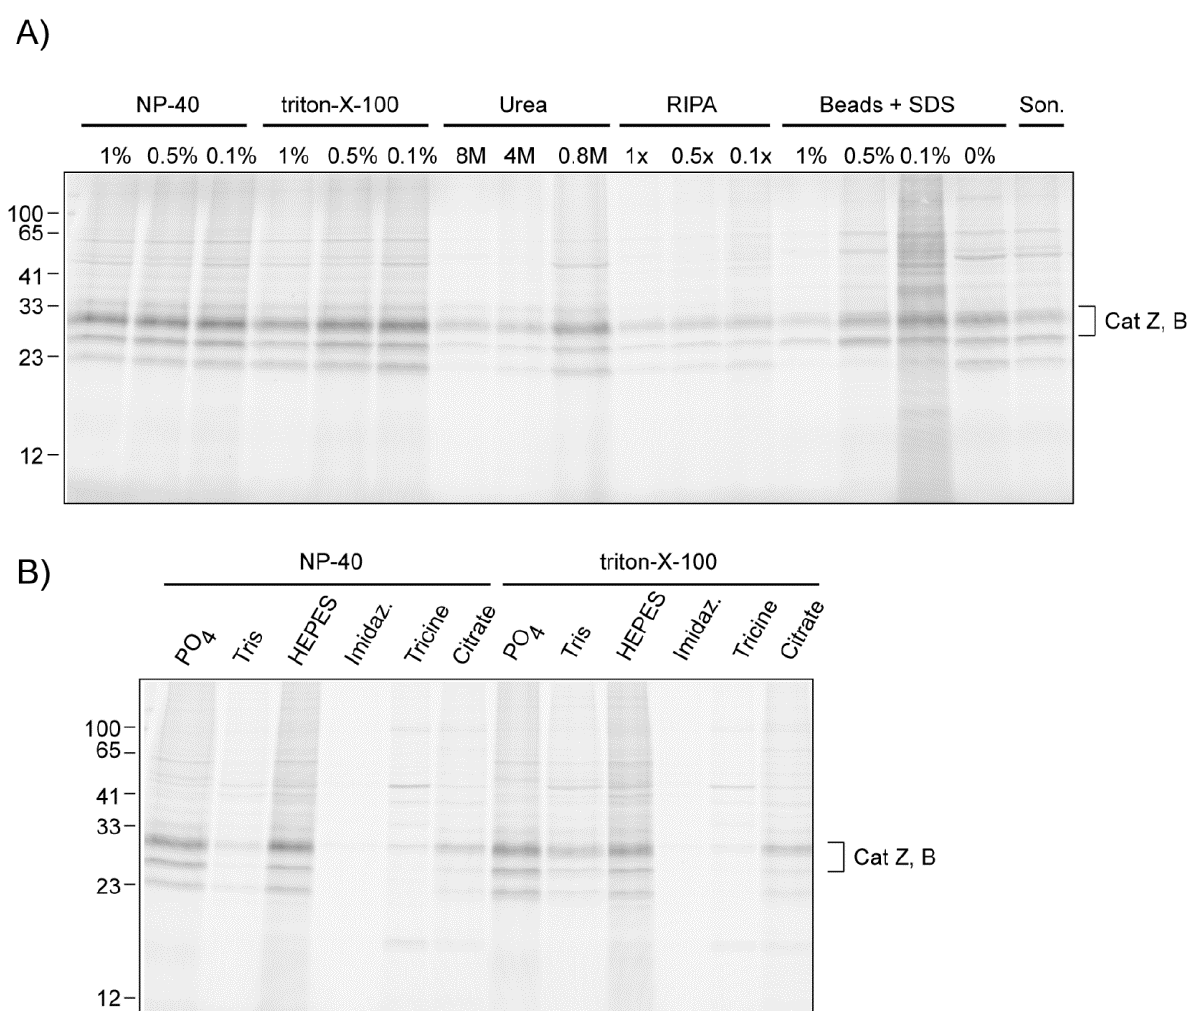
Figure 4. ( A ) Comparison of different lysis conditions on the tandem ABPP of cathepsins by Cu(I)-catalyzed click chemistry. All buffers except RIPA contained 100 mM sodium phosphate. SDS was added post lysis with glass beads. All protein concentrations were adjusted to 1 mg/mL. Click chemistry was performed for 1 h with 5 μ M of alkyne 3 , 2 mM THPTA, 1 mM CuSO , and 1 mM sodium ascorbate. ( B ) Comparison of different 4 buffering salts (all at pH 7.4; final detergent concentration 0.1%) on the tandem ABPP of